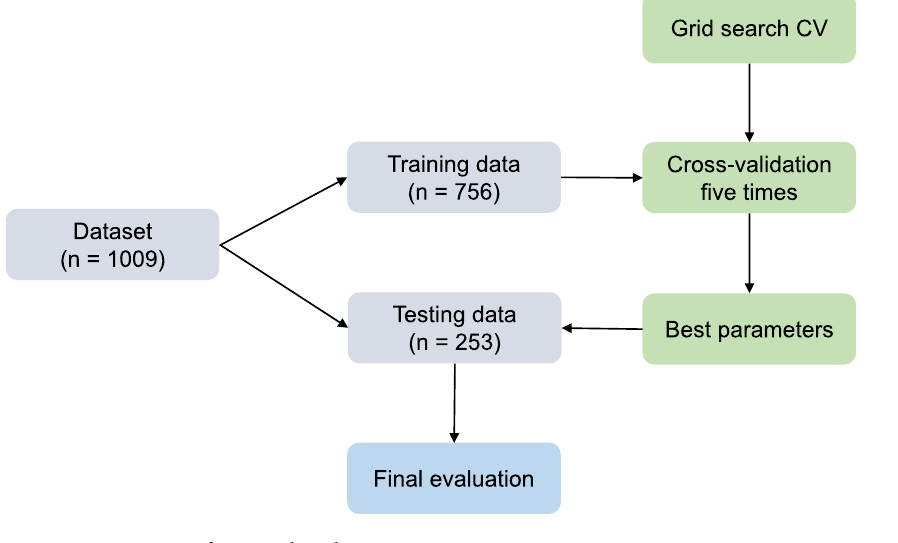
Figure 1. Overview of our machine learning process.